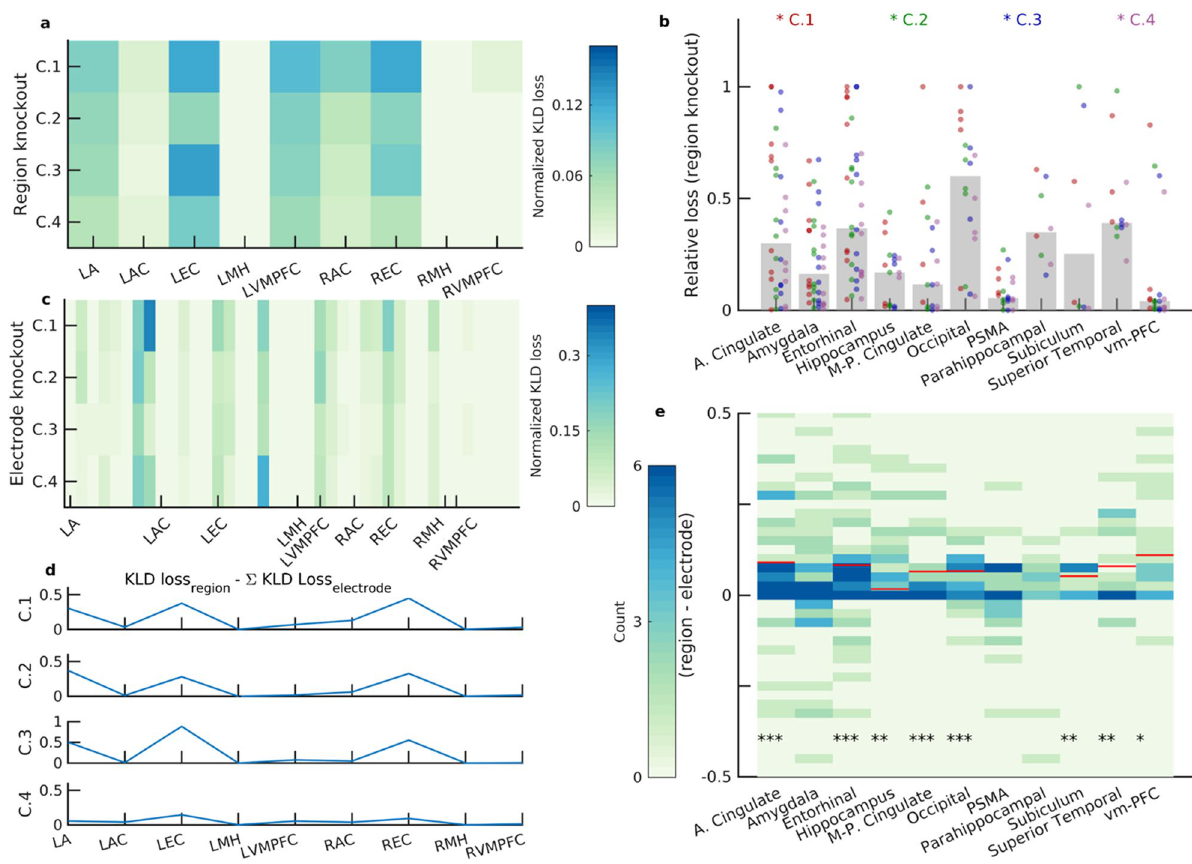
Figure 3. Identification of important regions in decoding characters: “The Whole Is Greater Than the Sum of its Parts.” ( a ) The change of KLD loss for each character (row) after knocking out a given region (column) for one participant is shown (Region Knockout). The value is normalized by the number of neurons in that region and demonstrates how the model performance deteriorated when excluding the units recorded from that region. Important regions are those with higher KLD loss values. L and R correspond to the left and right hemisphere, respectively. A: Amygdala, AC: Anterior Cingulate, EC: Entorhinal Cortex, MH: Middle Hippocampus, VMPFC: Ventro- medial Prefrontal Cortex. ( b ) The changes in KLD loss after knocking out regions are shown across participants. Different colored dots correspond to the changes in KLD loss for different characters. Bars indicate the median value of the change in KLD loss after region knockout. The following regions resulted in the most notable losses in decoding performance: anterior cingulate (36.11, [20.82, 53.78]%), entorhinal cortex (42.50, [27.04, 59.11]%), occipital (65.00, [40.78, 84.61]%), parahippocampal (37.50, [8.52, 75.51]%), and superior temporal (33.33, [9.92, 65.11]%). Reported are the percentage of losses above 0.5 (as well as the binomial fit confidence intervals).(N participants = 9). ( c ) The change in KLD loss for each character (row) after knocking out a given electrode (column) at a time is shown (Electrode Knockout) for an example participant (same as in a) . Similar to the region knockout results in (a), the loss value is normalized by the number of units recorded on each electrode. ( d ) The sum of the changes in KLD loss following electrode knockout (all electrodes within a region) was subtracted from the change in KLD loss following region knockout. Shown are these values for the four different characters (rows) from an example participant (same as in a and c). Positive values indicate that knocking out a whole region deteriorates the model performance to a greater extent. ( e ). When considering all regions from all participants, in most regions, the region knockout loss was greater than the sum of electrode knockout loss (each column, and its associated colormap, is the distribution of this measure and the red horizontal line indicates the median of the distribution for those that were significantly different from zero) as quantified by Wilcoxon signed-rank tests (*: p < 0.05; **: p < 0.01; ***: p <